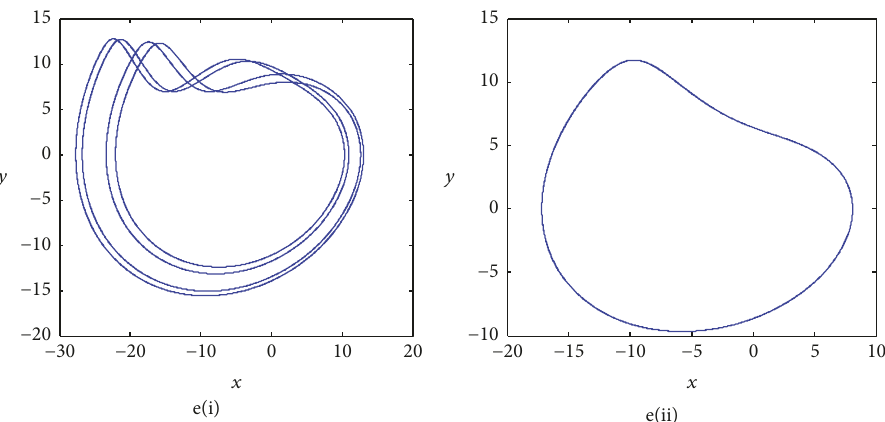
Figure 6: Numerical phase portraits showing the coexistence of multiple (two) solutions for different values of the control parameter 𝜇 . The values of the control parameters as well as initial conditions are listed in Table 1.